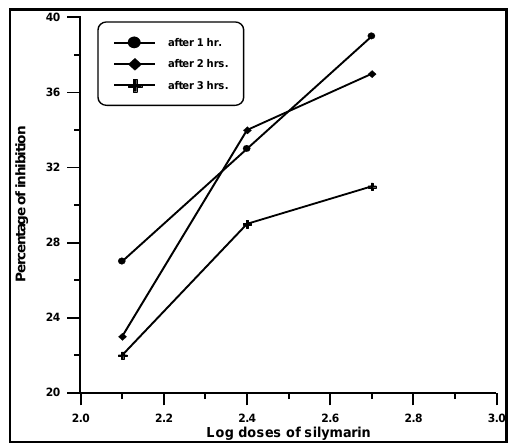
Figure (1): Dose-response effect of different doses of silymarin on egg albumin-induced acute inflammation in